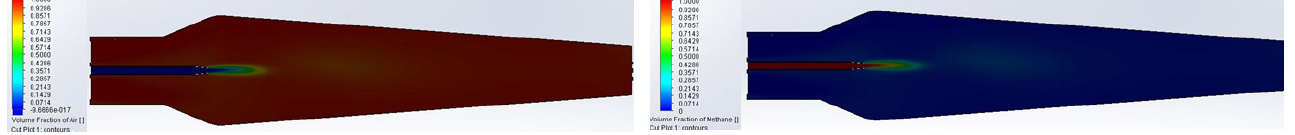
Figure 13. Volume fraction spatial distributions of gas and air in Solidworks Flow Simulation.